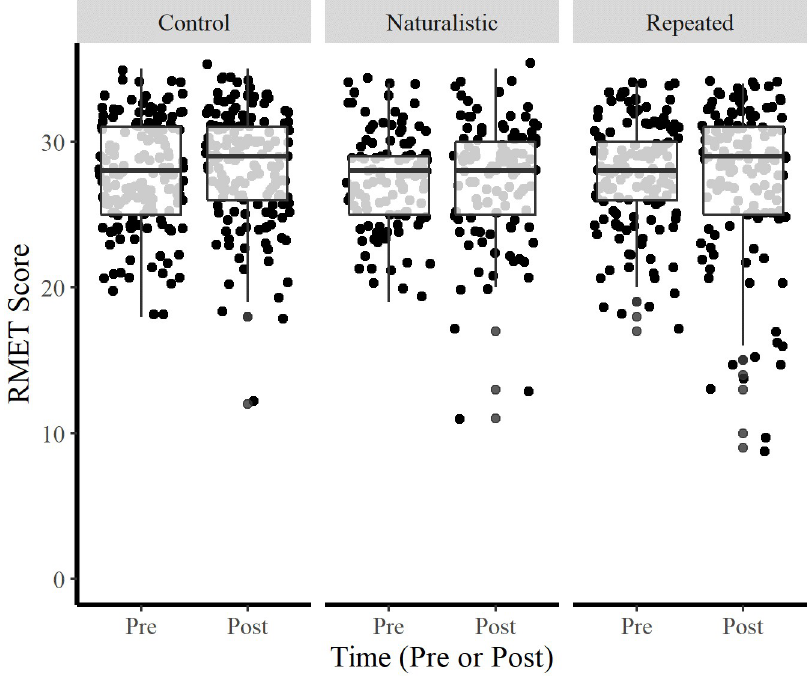
Fig 1. Pre- and Post-RMET score by condition. Bars represent one standard deviation from the mean.